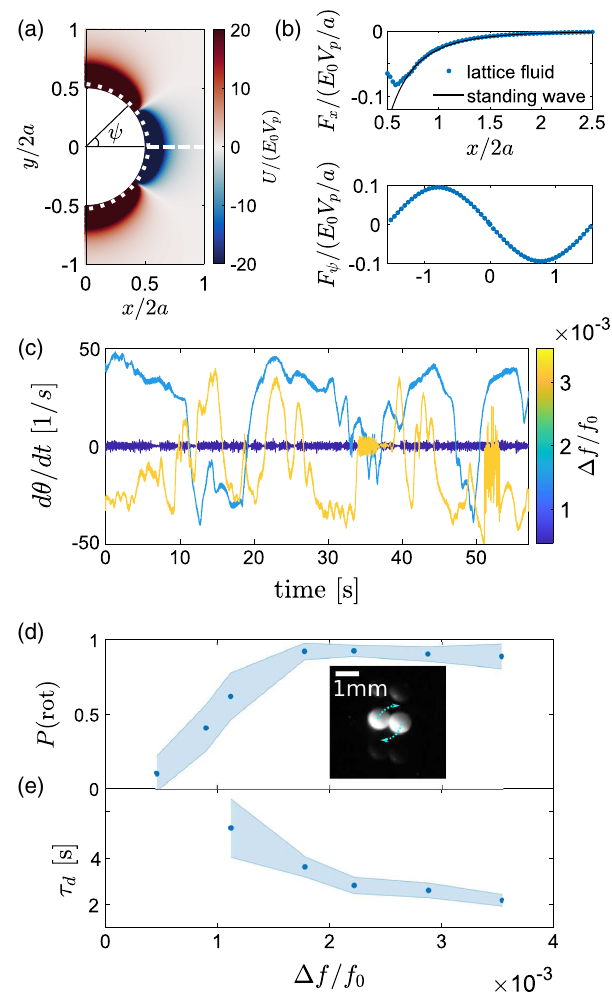
FIG. 2. Secondary acoustic forces drive self-assembly and rotation of levitated granular rafts. (a) Secondary acoustic potential due to a particle with radius a , computed using a scattering expansion, normalized by the energy density of the cavity E 0 , and the particle volume V p . (b) Secondary acoustic force between a pair of particles, computed using a scattering expansion (black solid line) and using a lattice simulation (blue markers). Top panel: horizontal force F x between two particles as a function of distance x between their surfaces [dashed white horizontal line in panel (a)]. Bottom panel: angular force F ψ on a particle displaced out of the nodal plane with angle ψ [ x= 2 a ¼ 0 . 1 , dotted circular contour in (a)]. (c) Example traces of rotation rate d θ =dt as a function of time, for a two-particle dimer consisting of a pair of 700 – 810 μ m polyethylene particles, at different detuning parameters Δ f=f 0 . (d) Probability of dimer rotation P ð rot Þ as a function of Δ f=f 0 . Shaded areas indicate the standard error. (e) Plot of the decorrelation time τ d for the rotation rate of a pair of particles, as a function of Δ f=f 0 . Shaded areas indicate the standard error. Data are not plotted for the smallest detuning parameters, for which there is no significant change in the rotation over